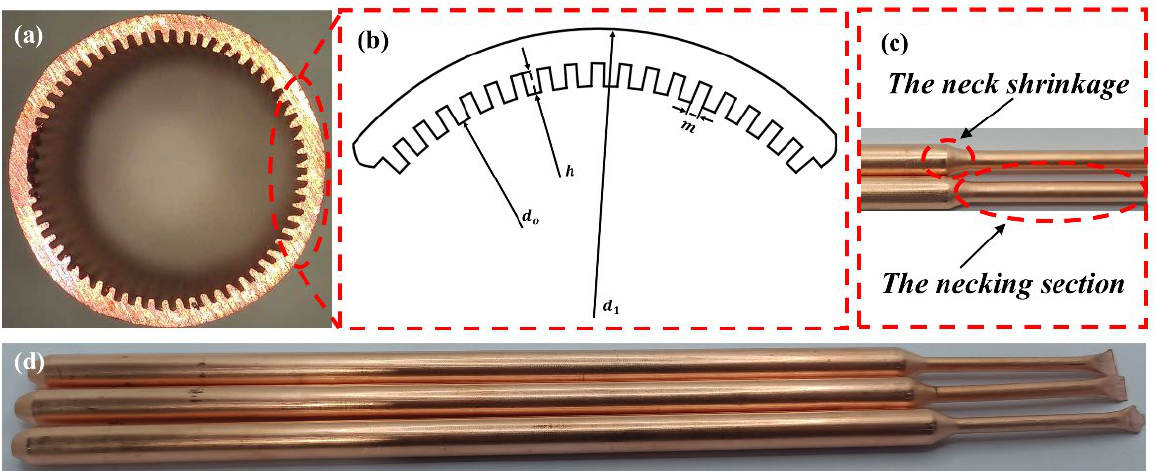
Figure 1. A schematic diagram of TSHP. ( a ) Cross section of the heat pipe; ( b ) geometrical characteristics of grooves; ( c ) the necking shrinkage during the necking section; ( d ) the overview of TSHP.